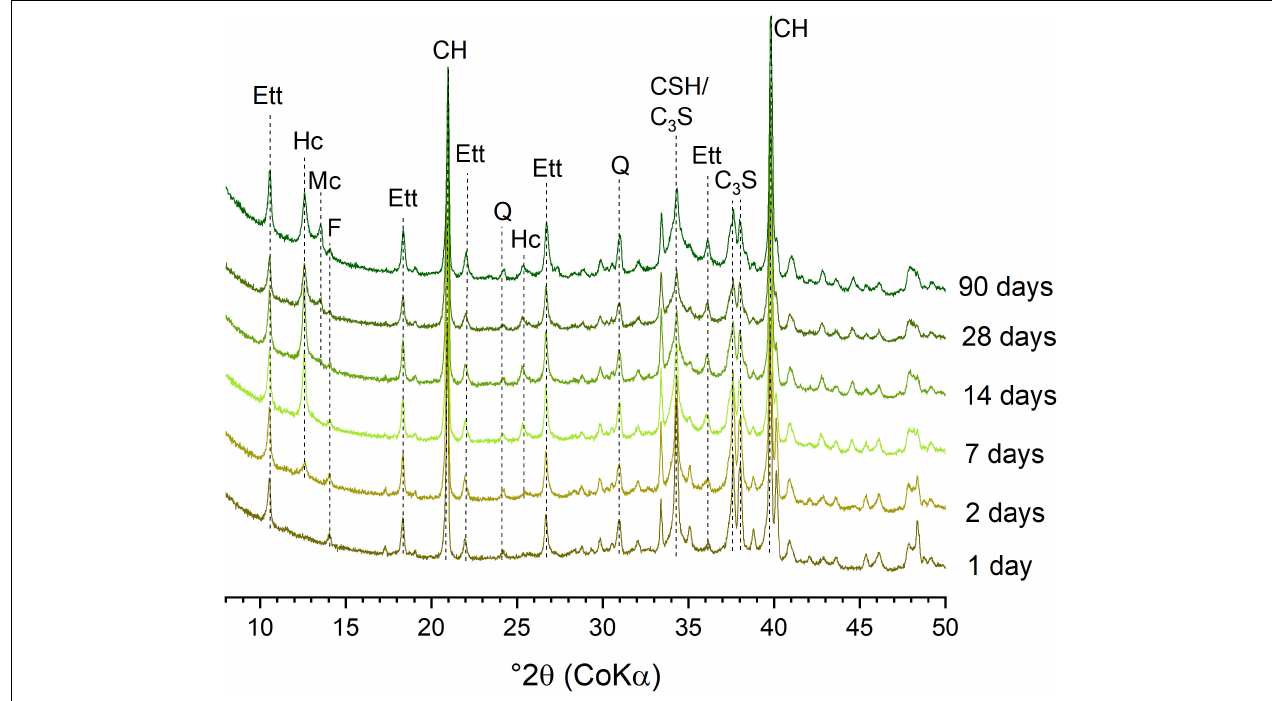
FIGURE 5 | XRD scan time series (1–90 days) of the hydration of cement blended with fine classified fly ash. The main XRD reflections are assigned to the corresponding phases: Ett, ettringite; Hc, hemicarboaluminate; Mc, monocarboaluminate; F, ferrite (C 4 AF); CH, portlandite; Q, quartz; CSH, C-S-H; and C 3 S, alite.